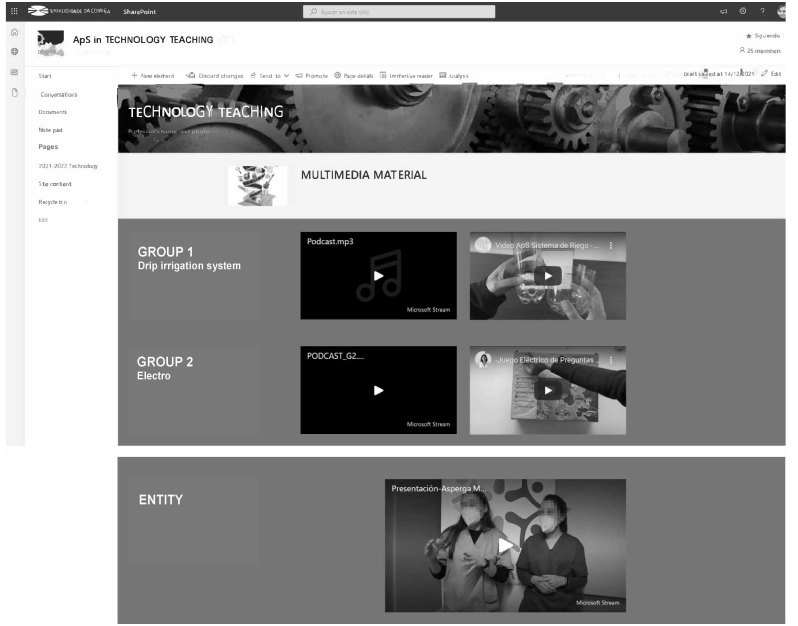
Figure 1. Workspace using the e-learning platform: communication tools and multimedia